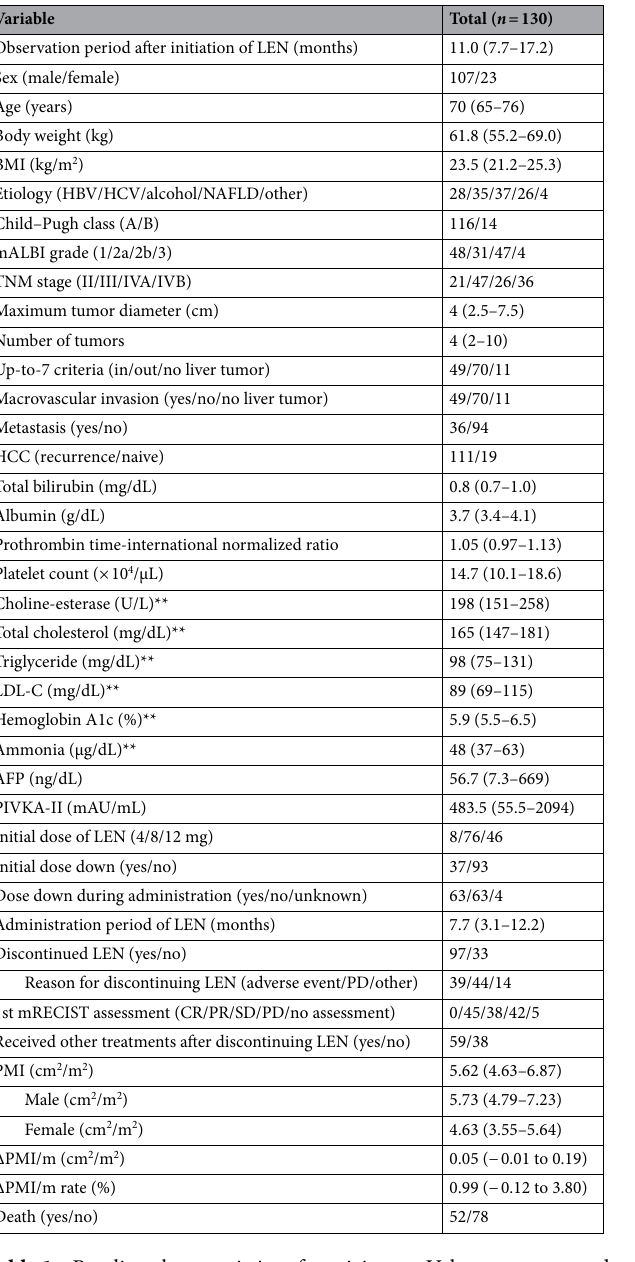
Table 1. Baseline characteristics of participants. Values are presented as the median (interquartile range). LEN lenvatinib, BMI body mass index, HBV hepatitis B virus, HCV hepatitis C virus, NAFLD non-alcoholic fatty liver disease, mALBI modified albumin-bilirubin, TNM tumor node metastasis, HCC hepatocellular carcinoma, LCL-C low density lipoprotein cholesterol, AFP alpha fetoprotein, PIVKA-II protein induced by Vitamin K absence or antagonists-II, PD progressive disease, mRECIST Modified Response Evaluation Criteria in Solid Tumors, CR complete response, PR partial response, SD stable disease, PMI psoas muscle